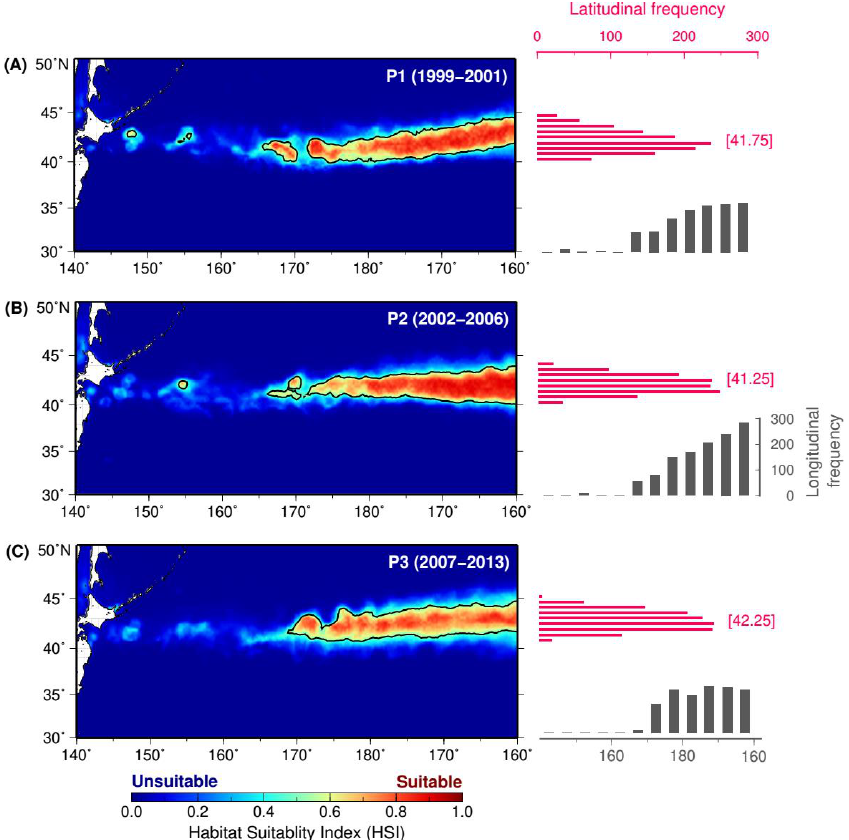
Figure 5. Spatial maps of potential squid habitat (left panels) with corresponding zonal (gray bars) and meridional (red bars) frequencies (right panels) for the following periods: ( A ) P1 (1999–2001), ( B ) P2 (2002–2006), and ( C ) P3 (2007–2013). Overlain on the spatial maps are contours delineating the regions with moderate to high squid habitat suitability (HSI ≥ 0.5). Latitudinal bin corresponding to the HSI frequency peaks for each period were also labeled (values in brackets).